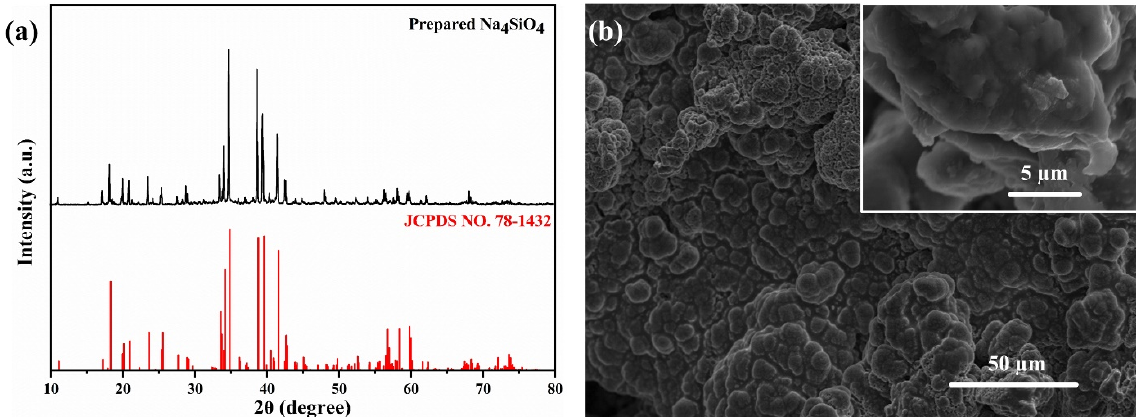
Figure 1. ( a )XRD patterns and ( b )SEM images of the Na4SiO4 synthesized at 600